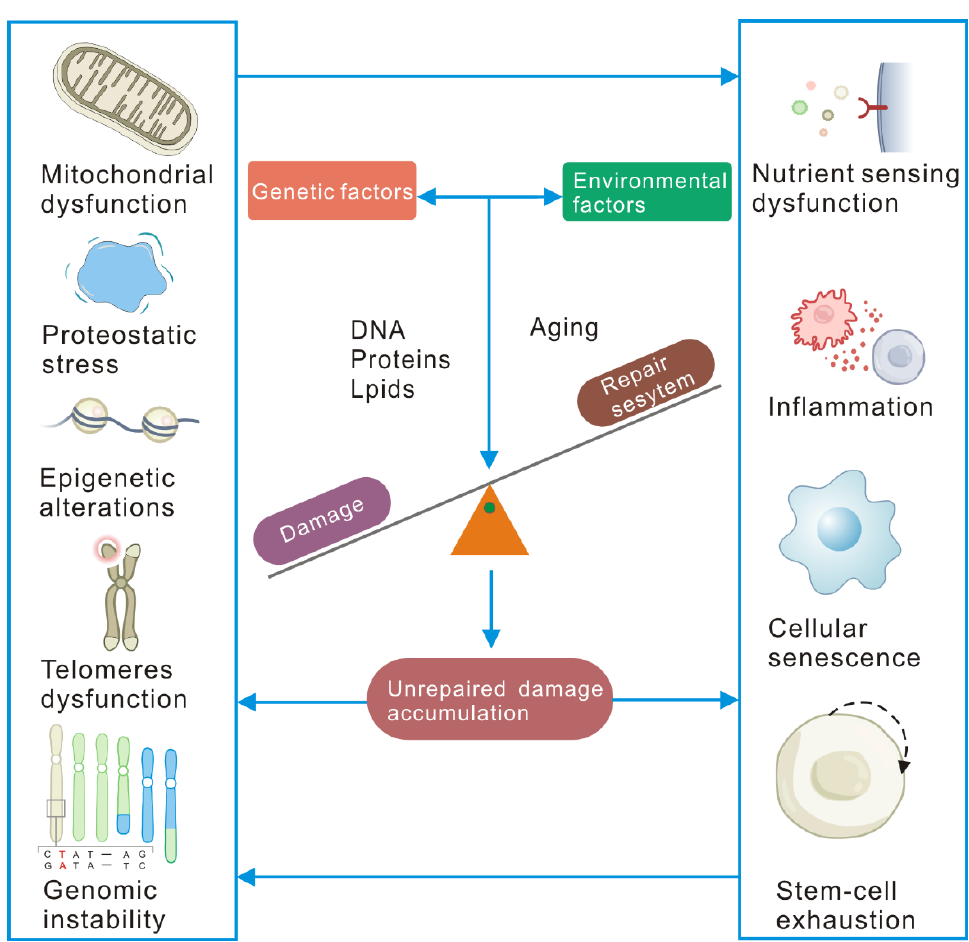
Figure 2. Diagram of the major influences and mechanisms by which macromolecular damage in- duces aging. Damage insults (genotoxic stress, oxidative stress, etc.) in genetic or environmental factors damage macromolecules (mainly including DNA, proteins, and lipids) during the aging pro- cess, causing intracellular damage to accumulate. At the same time, the repairability in the cell de- clines with aging, which causes the accumulation of unrepaired damage in the cell.